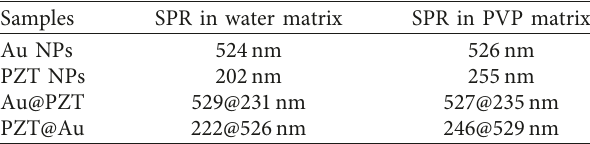
Table 1: SPR in different solutions for all